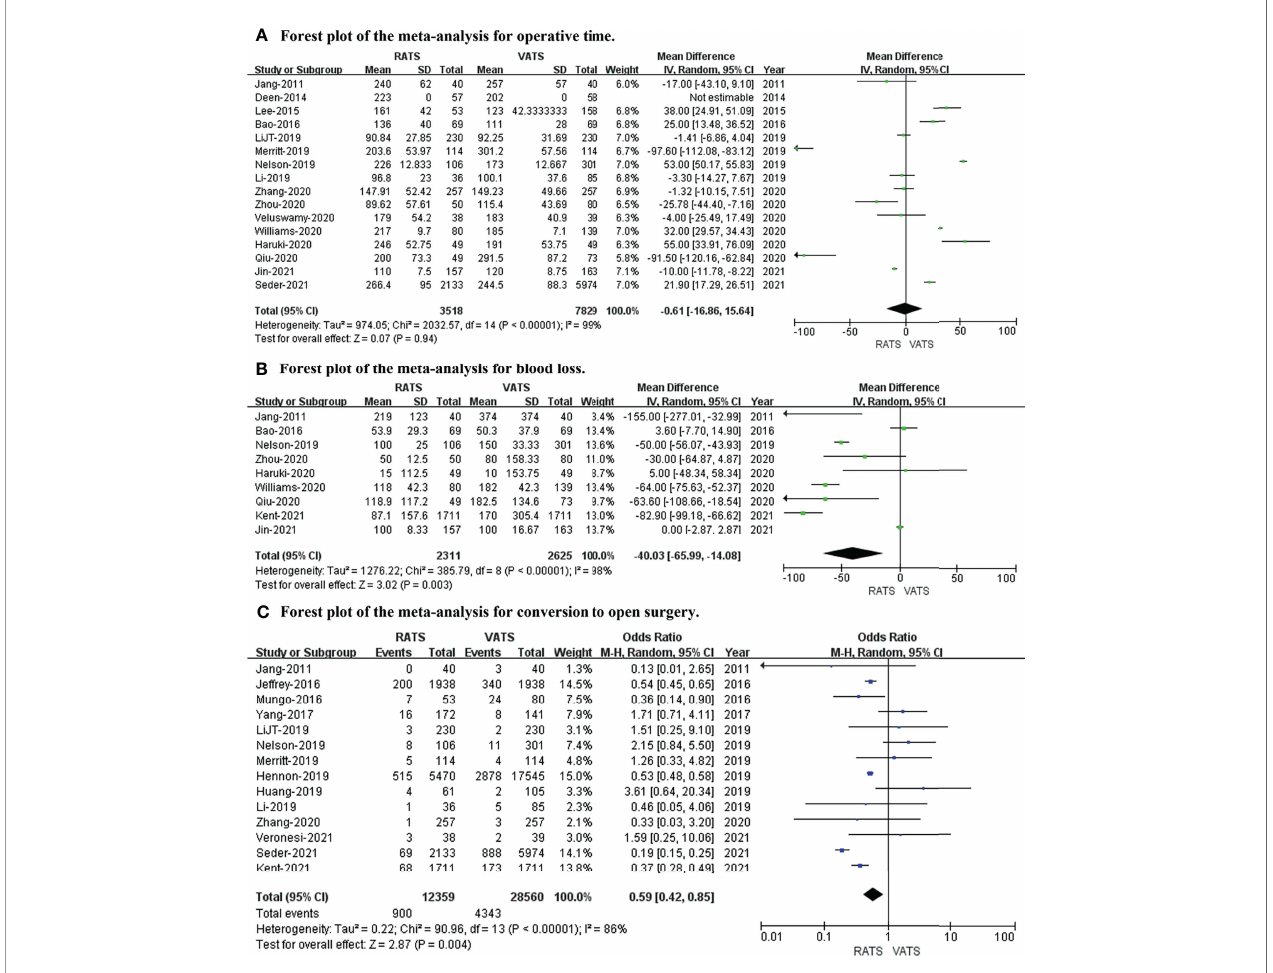
FIGURE 2 | Forest plot of the meta-analysis for intraoperative outcomes. (A) Forest plot of the meta-analysis for operative time. (B) Forest plot of the meta-analysis for blood loss. (C) Forest plot of the meta-analysis for conversion to open